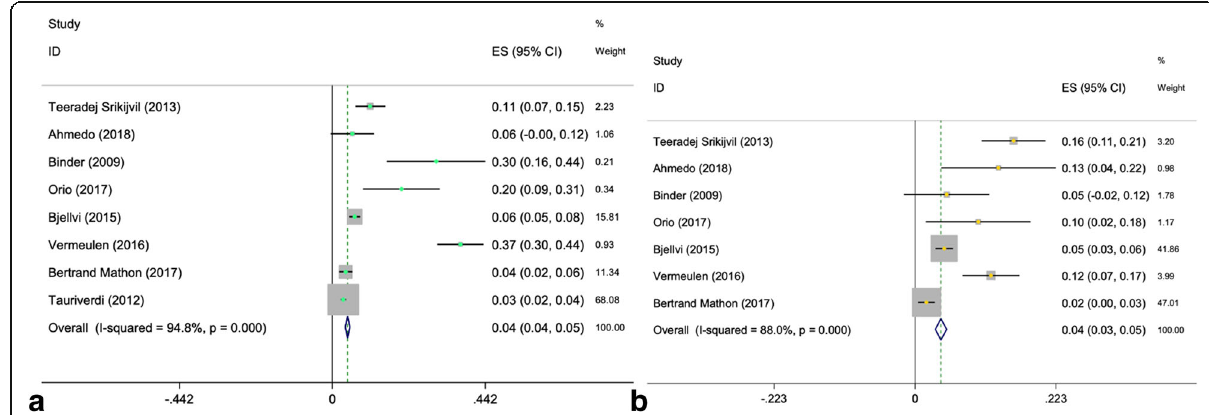
Fig. 5 The overall prevalence of neurological ( a ) and surgical ( b ) complications of epilepsy surgery